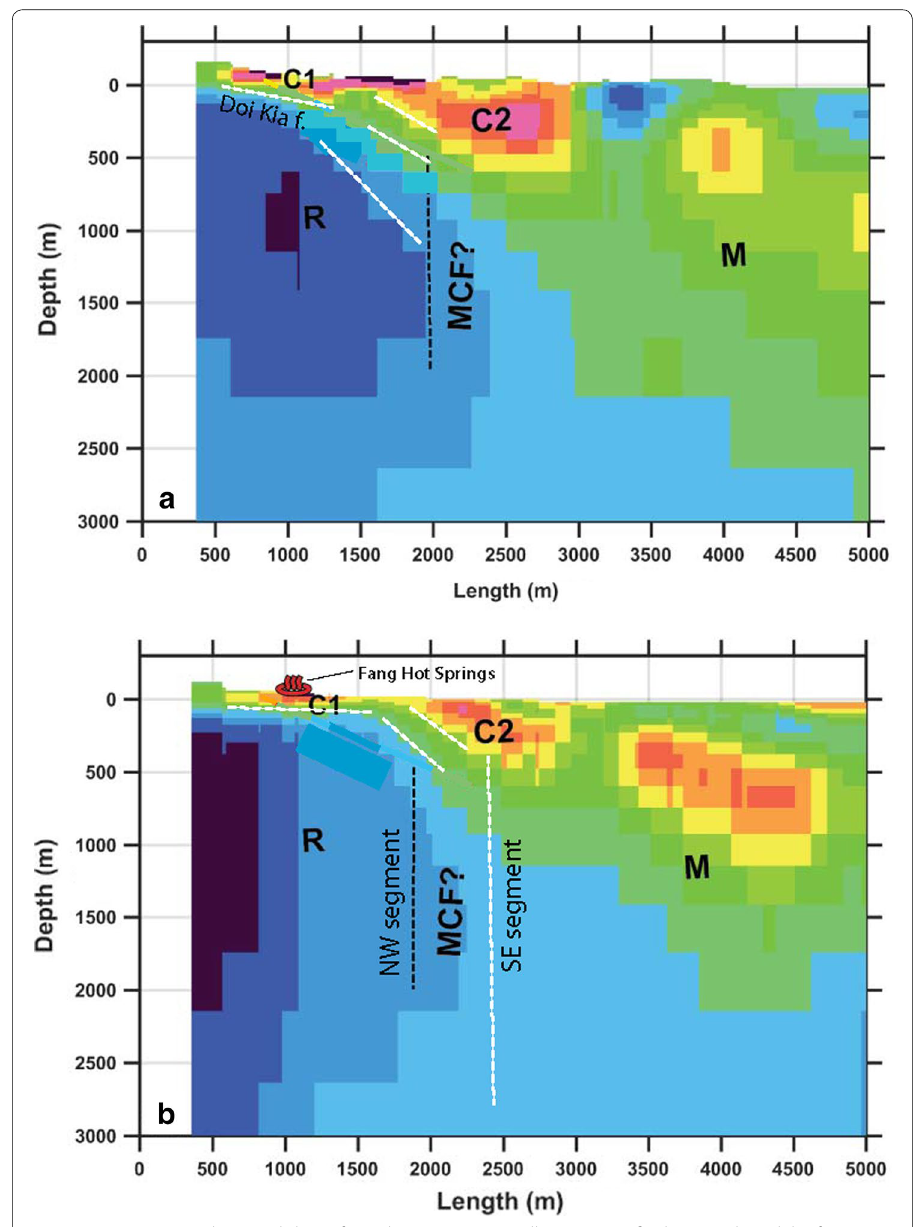
Fig. 22 Cross-sectional (vertical slices) from the 3D-magnetotelluric survey (final inverted model) of Amatyakul et al. (2016). Stations discussed in text refer to length in meters from the northwest end of profiles. Label “R” is interpreted as crystalline rock. Label “M” is interpreted as Cenozoic basin fill sediments. Profile a is 1 km west of the hot springs. The shallow (< 200 m) low resistivity anomaly “C1” was interpreted earlier in Amatyakul et al. (2016) as a manifestation of the hot springs. Because it lies west of the geothermal area, it is now believed to be the shaly Paleozoic sediment and perhaps the cataclastic clayey rock at the base of the Doi Kia fault. Southeast of the Mae Chan fault, the “C2” anomaly is in the shaly Cenozoic sediment. The C2 low resistivity anomaly may be caused by clay and not by hot pore water. The white line, below 400 m depth, corresponds to the N–NE trending deep structure indicated in Fig. 21b, and shows an apparent dip of 50°SE. Profile b is through the hot springs area and shows the flat lying, shallow (< 80 m deep) low resistivity anomaly at the geothermal area, labeled “C1.” Because Profile b crosses only crystalline rocks from stations 1 to 1600, we believe “C1” on Profile ( b ) is caused by shallow hydrothermal alteration zones along fractures in the crystalline rocks. To the southeast, Profile b crosses through the stepover zone between segments of the Mae Chan fault from stations 1650–2400. The apparent 36°SE dip between those stations also occurs on profile a and may be a tilted structure within the stepover